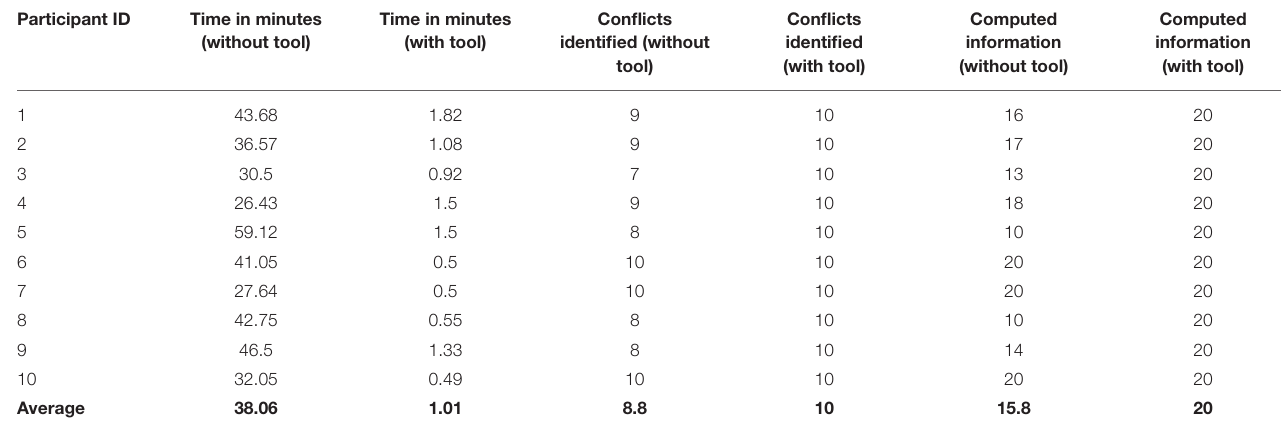
TABLE 1 | Raw results of the Charrette